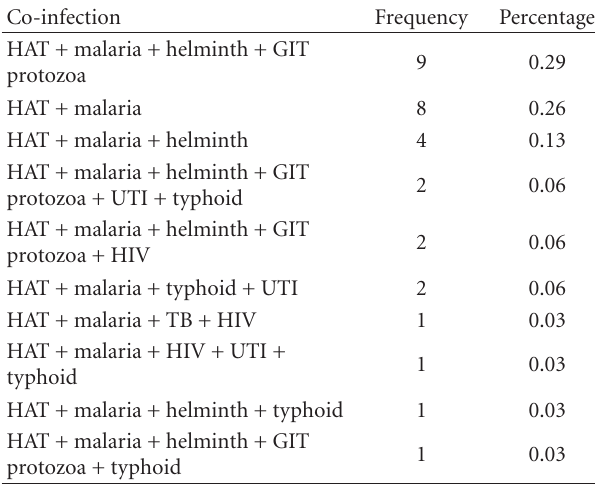
Table 3: Pattern of coinfections in 31 HAT patients in NSSRH, Alupe, Kenya, from 2000 to